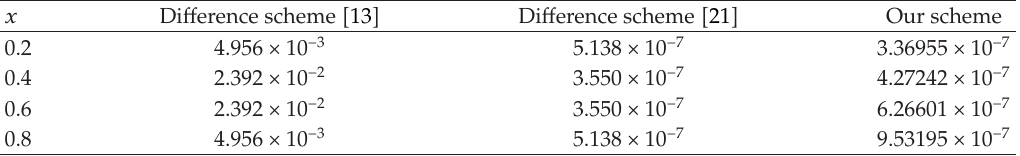
Table 6: The absolute error of Example 4.3 for di ff erence schemes and our scheme at t (cid:3) 1 .